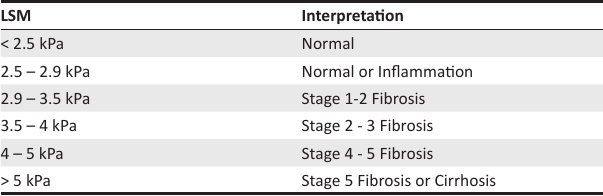
TABLE 1: Interpretation of the stage of fibrosis based on the liver stiffness measurement as suggested by Venkatesh et al.